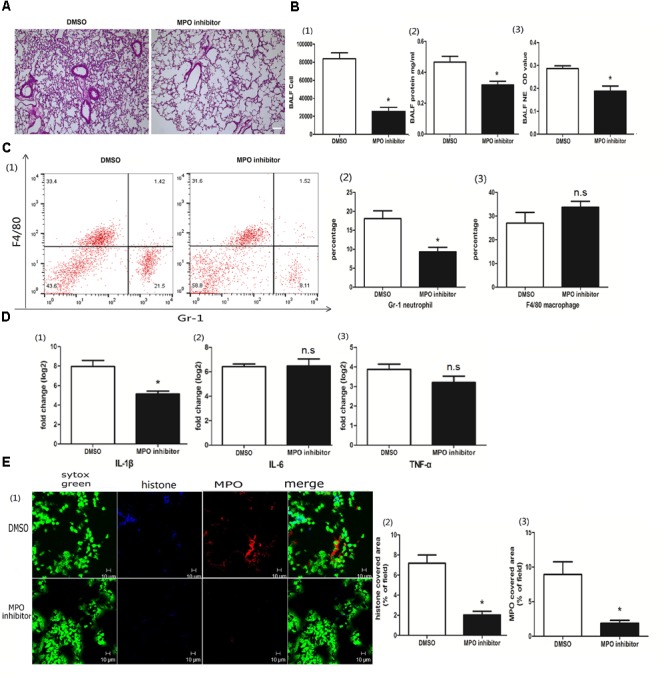
MPO contributed to poly I:C induced NETs. (A) Infiltration of inflammatory cells and interstitial edema in the lung lobe were decreased in the ALI mice treated with an MPO inhibitor, bar = 100 μm; (B-1) cells were counted in the BALF, ∗p < 0.05; (B-2) protein concentration in the BALF, ∗p < 0.05; (B-3) neutrophil elastase (NE) activity was evaluated in the BALF, ∗p < 0.05; (C) flow cytometry analysis of the BALF cells, ∗p < 0.05; (D) inflammatory cytokines IL-1β, IL-6, and TNF-α in the lung were quantified using qRT-PCR, ∗p < 0.05; (E) NETs were observed and quantified in lung tissues from mice administered poly I:C and an MPO inhibitor.